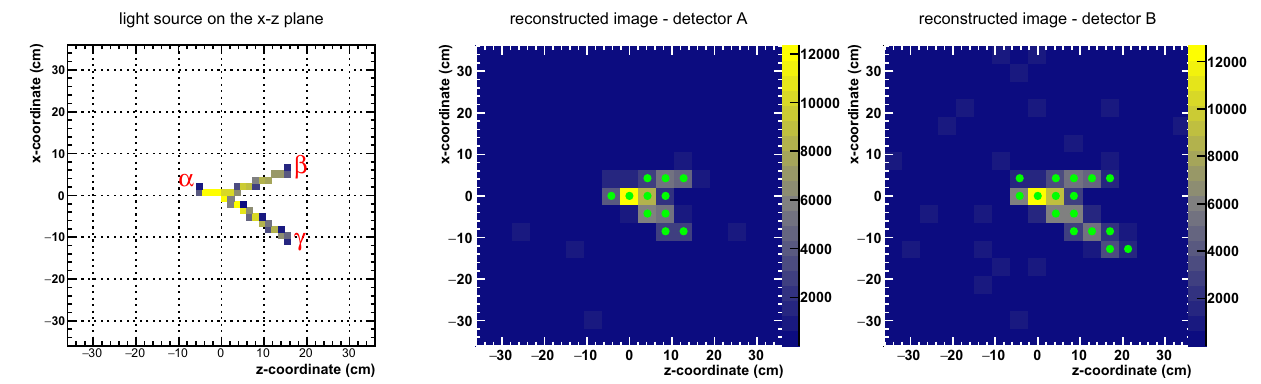
Fig. 8 Left frame – simulation of a neutrino interaction. The three tracks do not lay on the same plane. Central and Right frames show the reconstructed image in the x − z view. The superimposed green dots